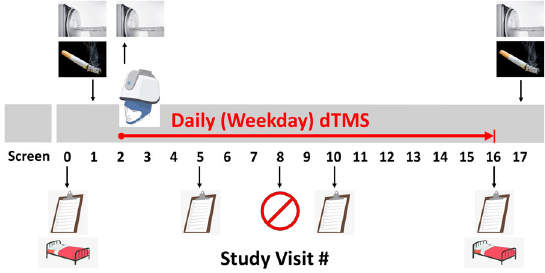
Fig. 2 Overview of study procedures. The study included pre- and post-treatment smoking self-administration sessions (cigarette graphic), which were preceded by overnight inpatient stay to monitor smoking abstinence (bed graphic); weekday deep repetitive transcranial magnetic stimulation (dTMS) treatment for 15 weekdays over 3 weeks (Visits 2-16; TMS helmet graphic), and three functional MRI scans (MRI scanner graphic), during which ASL was acquired (once at baseline, once after the fi rst treatment, and once after the fi nal treatment). MRI was acquired before the smoking self- administration on Days 1 and 17, and after the fi rst dTMS session on Day 2. Resting-state functional connectivity was also acquired during the same MRI sessions, but only during the fi rst and last scan (Visits 1 and 17). Clinical assessment with the PANSS was acquired at four time points (clipboard graphic), approximately once per week. Participants made a quit attempt approximately by Visit 8 (red prohibition graphic). Screening/consenting could occur up to a week before primary study procedures